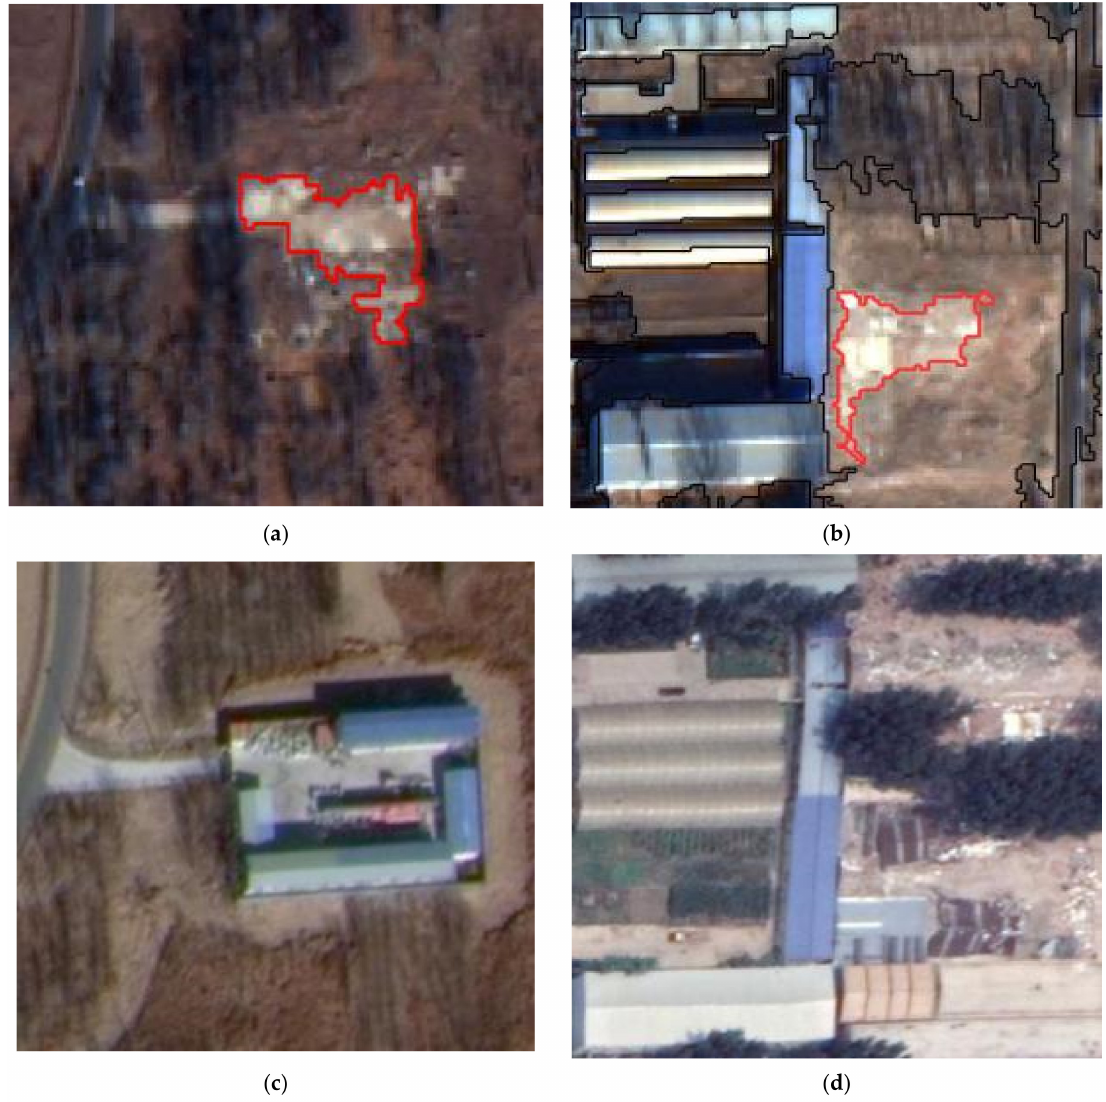
Figure 27. The construction waste accumulation area after cleaning: ( a , b ) wrongly classified into construction waste after demolishing and cleaning, ( c , d